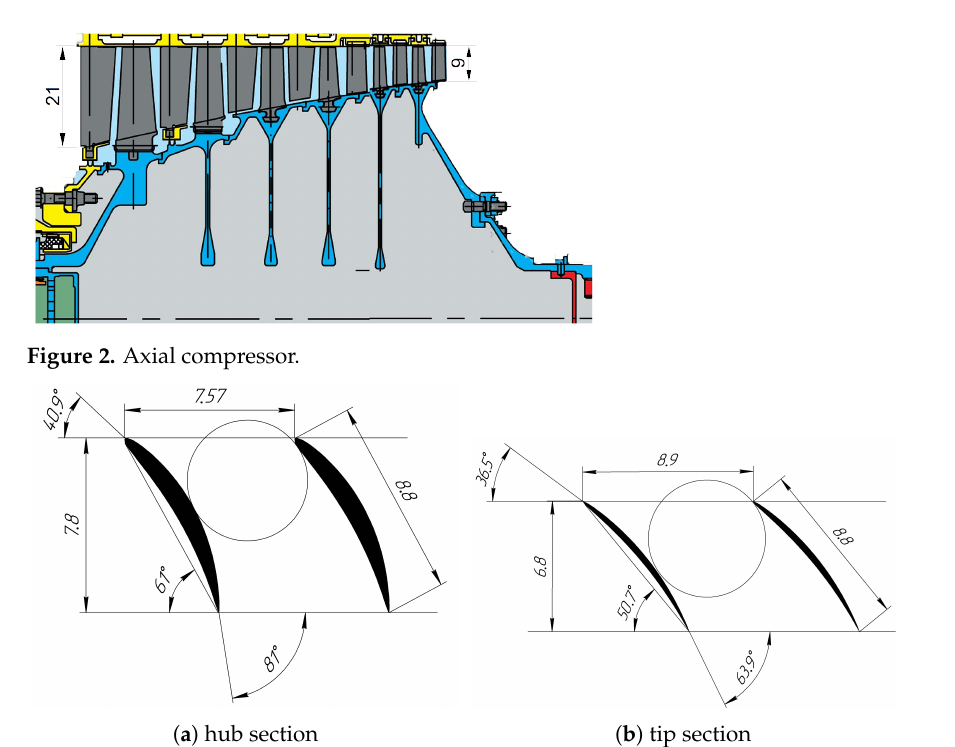
Figure 3. Profile of the first stage blade.